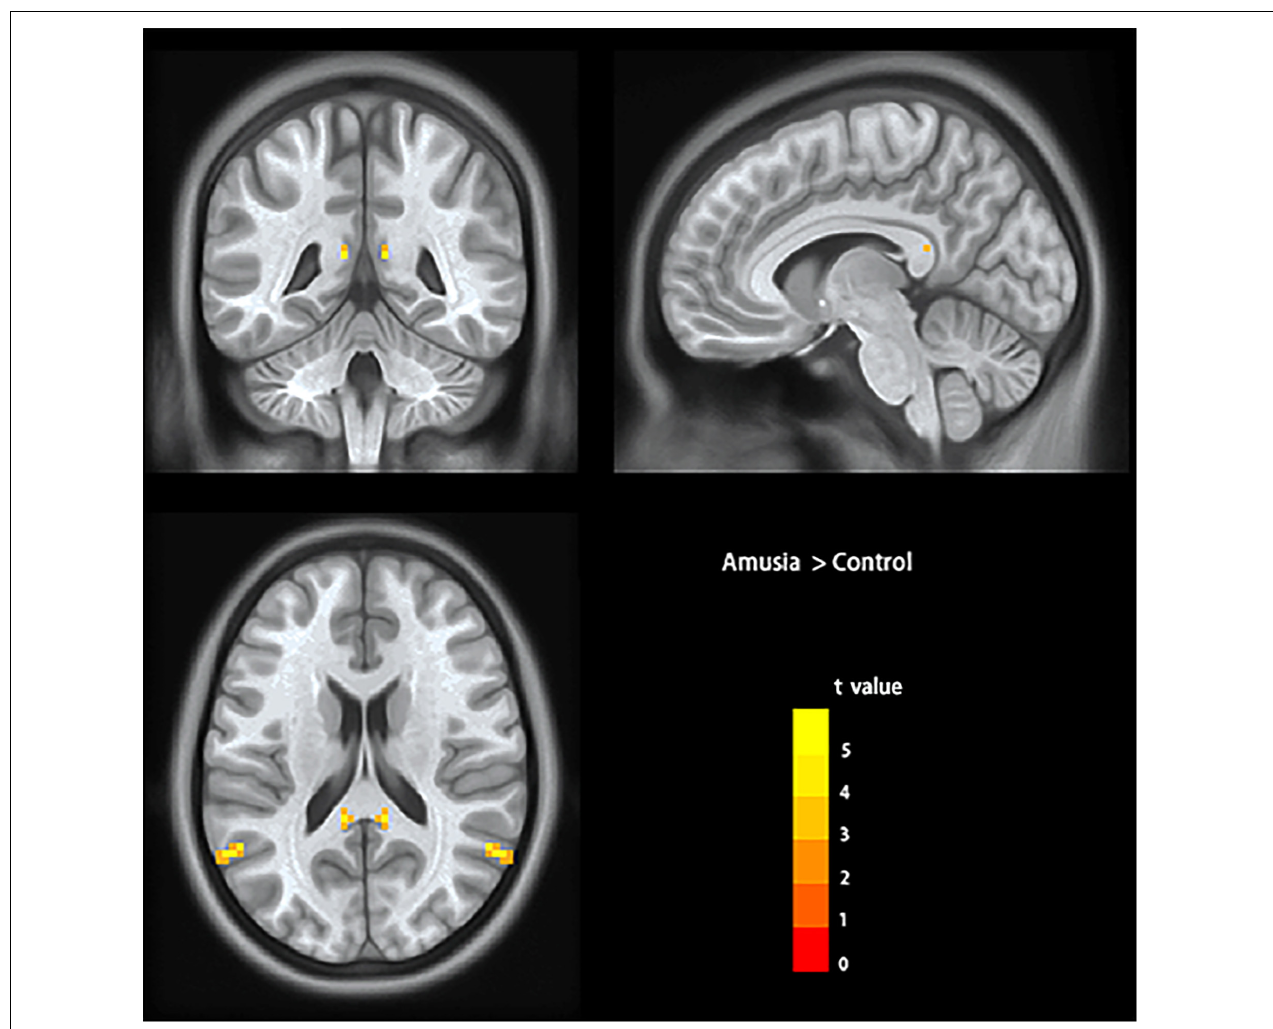
FIGURE 1 | Voxel-mirrored homotopic connectivity results showed significantly increased homotopic functional connectivity (signal voxel significance was set at p < 0.001, TFCE corrected p < 0.05) in posterior superior temporal gyrus (pSTG) and posterior cingulate cortex (PCC) in amusics. The color bar indicates the t values of two-sample t -test